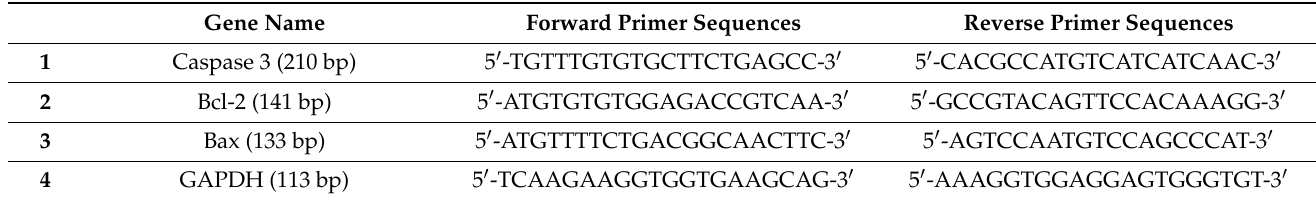
Table 2. Primer sequences for quantitative real-time polymerase chain reaction